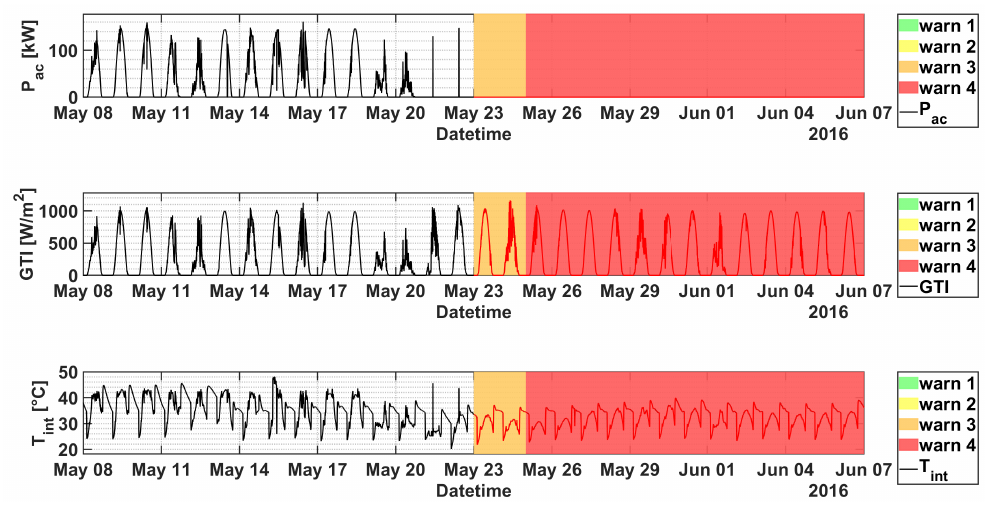
Figure 8. From top to bottom: P ac , GTI and T int of inverter 3.5 of plant C as a function of datetime in the period 8 May–7 June 2016. The warning levels are superimposed for convenience.